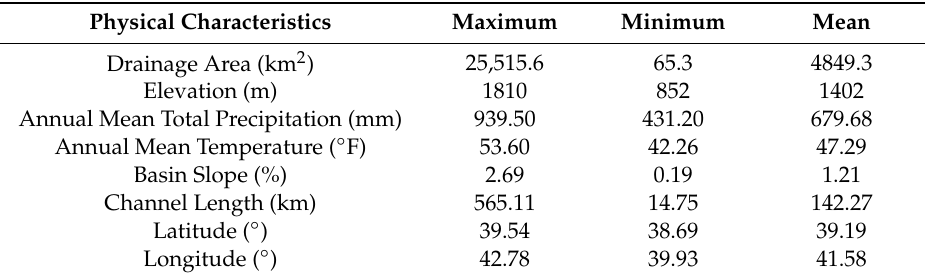
Table 3. Statistics of physical characteristics used in the Middle Euphrates Basin.